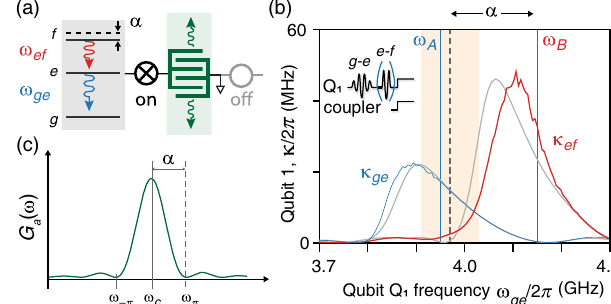
FIG. 2. Single-qubit frequency- and state-dependent energy decay. (a) We monitor the decay of Q 1 ’ s state after excitation respectively to j e i and j f i [pulse sequence is in inset of (b)], dominated by emission of phonons into the IDT. Q 1 ’ s coupler is set to maximum coupling and Q 2 ’ s coupler is turned off. (b) Fitting the population evolution (see Ref. [40]) enables us to extract the transition rate κ of transition g - e (blue) and the ge transition rate κ of transition e - f (red) as a function of Q 1 ef frequency. The frequency dependence of each transition rate is seen to follow the frequency dependence of the IDT conductance (c). We identify two operating points ω and ω . At frequency A B ω ¼ ω , phonon emission on the g - e transition dominates, ge A = 2 π ¼ 3 . 95 GHz within the resulting in phonon emission at ω ge mirror bandwidth (orange), while decay on the e - f transition is ¼ ω ¼ 2 π × 4 . 15 GHz, suppressed. Similarly, at frequency ω ge B phonon emission on the e - f transition dominates, resulting in ¼ ω − j α j ¼ 2 π × 3 . 97 GHz (gray phonon emission at ω ef ge dashed line), also within the mirror bandwidth, while decay on the g - e transition is